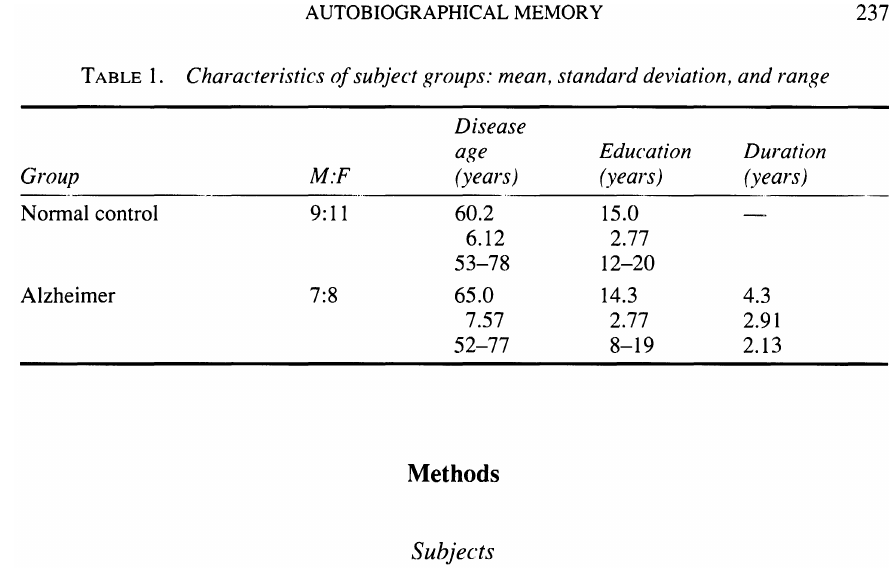
TABLE 1. Characteristics of subject groups: mean, standard deviation, and